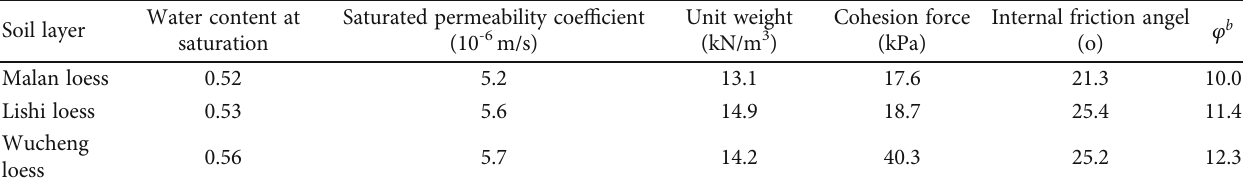
Table 1: Soil parameter values of the